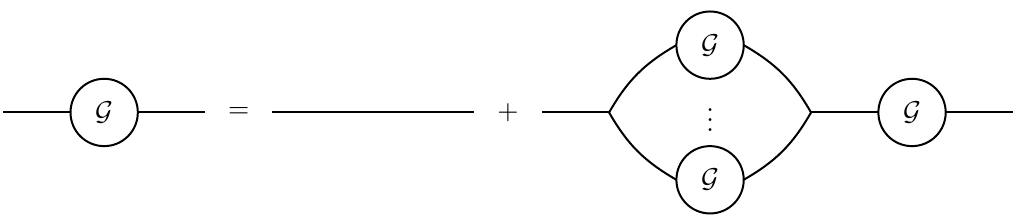
Figure 3. Supergraph representation of the super-Schwinger-Dyson